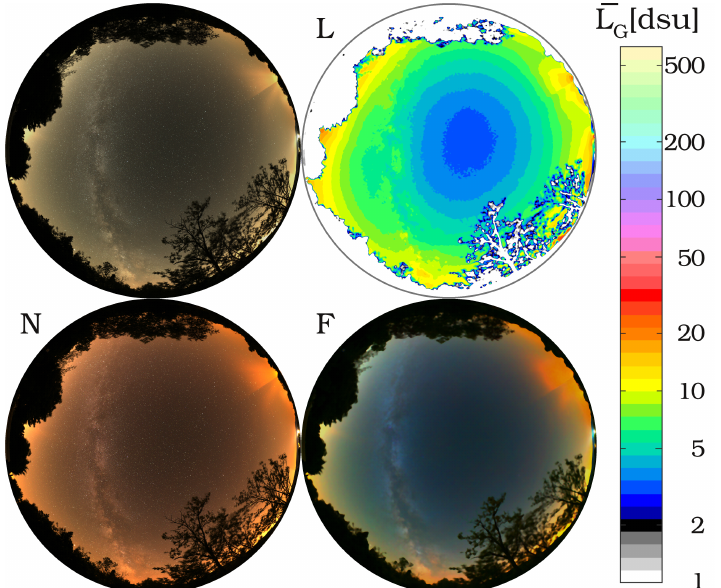
Figure 2. Radiance and colour analysis of an all-sky image. RGB image with dsu colours ( top left ); L: Radiance map in G band; N: real colour representation; F: colour enhanced photo to emphasize the different